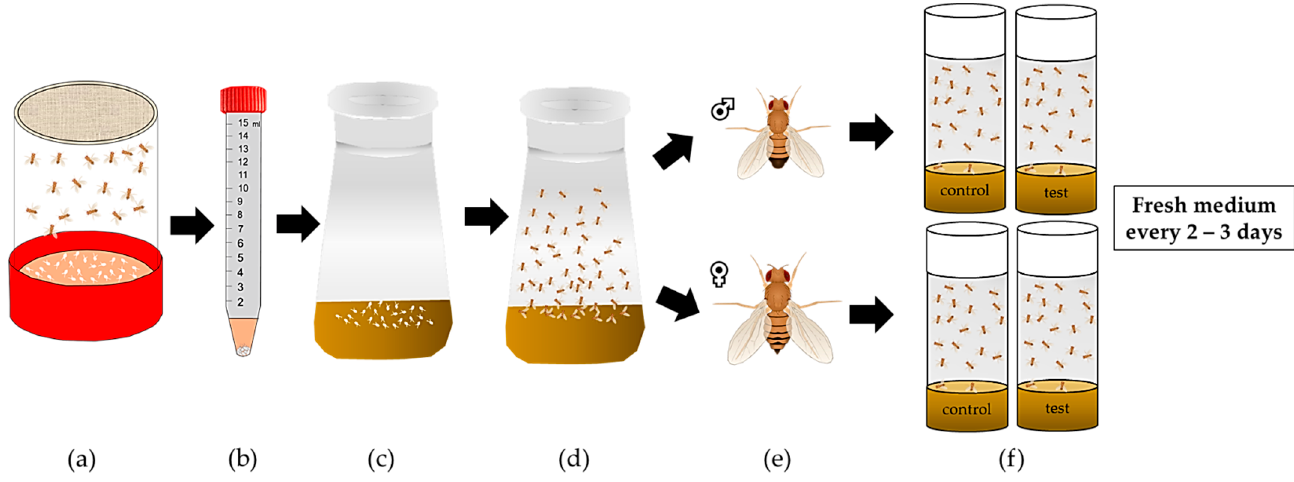
Figure 7. Implementation of a lifespan experiment. ( a ) Adult flies are transferred into an egg-laying cage covered by a grape agar plate with active yeast paste. After 24 h, the grape agar plate is replaced and inoculated with only a small spot of active yeast paste. ( b ) The next day, flies are removed from the cage, and the laid eggs are removed from the surface of the plate with a cotton swab and a physiological buffer or saline solution. The egg suspension is rinsed three times with buffer or saline solution before ( c ) aliquots of the egg suspension are transferred to cultivation medium, where egg-to-adult fly development occurs within approximately 10 days. ( d ) After hatching, the mixed fly populations are transferred to fresh standard medium for mating. ( e ) Forty-eight hours later, the adult flies are usually separated into male and female cohorts. ( f ) Approximately 20 to 30 flies per sex are placed in a vial with a control or experimental medium. Four to five replicates are used to obtain a total number of at least 100 flies per sex and treatment. The flies are transferred to fresh medium every 2 to 3 days, and the number of dead flies is documented at each transfer. This documentation is continued until all flies are dead (modified from [72,73]).